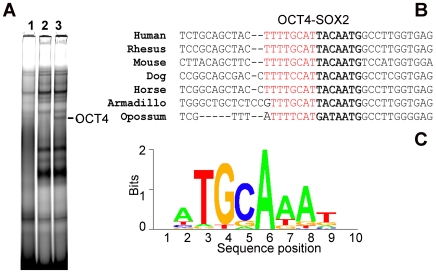
The NANOG promoter harbours an evolutionary conserved binding site.The conserved binding site is shown for OCT4 (red) and SOX2 (bold). A: Bandshift showing a supershift with OCT4 antibody, using NCCIT-derived nuclear extracts and a Cy5 labelled probe in the 5′region of the NANOG promoter bearing the OCT4-SOX2 motif. Binding specificity was tested using oligonucleotide competitors. 1) 20-fold excess of unlabelled competitor. 2) Supershift with OCT4 (sc9081) antibody. 3) Nuclear extract with Cy5-labelled probe. B: Alignment of the OCT4-SOX2 binding sequence in multiple species. C: Bitscore model of the re-constructed OCT4 PWM. Note that the OCT4 PWM sequence is presented in the opposite strand with respect to the sequence shown in (B) above.